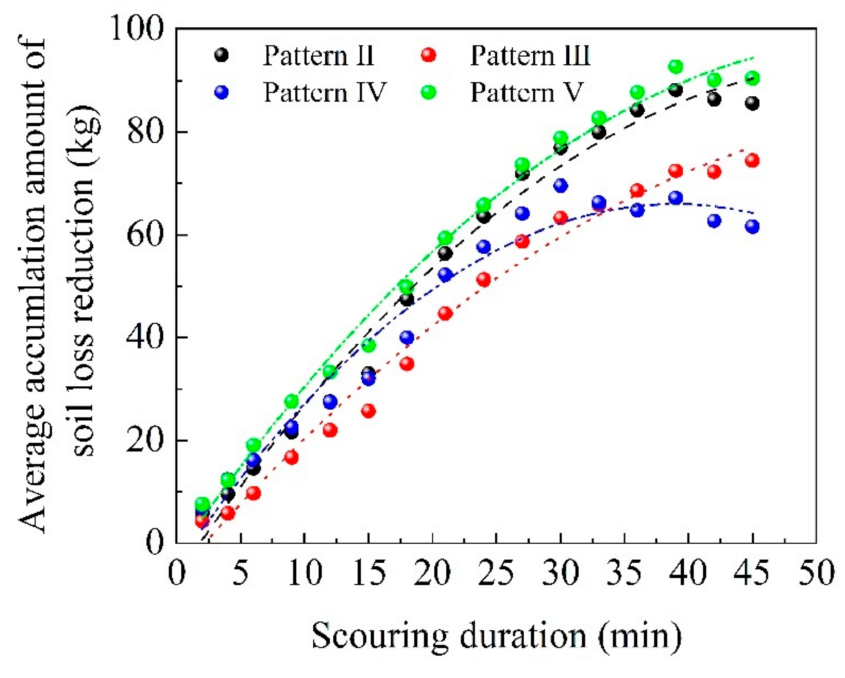
Figure 9. Relationship between average accumulation amount of soil loss reduction and scouring duration under different grass strip